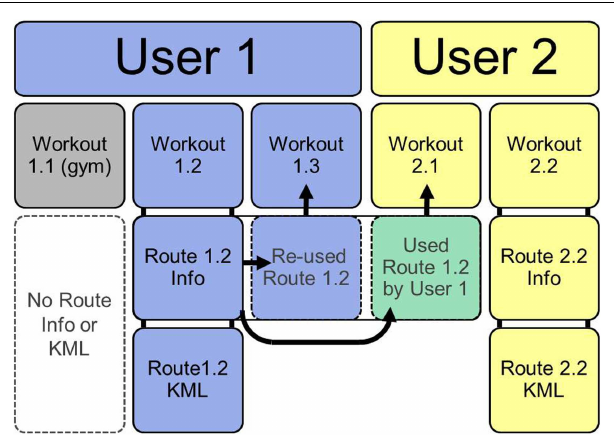
FIGURE 1 | Structure of MapMyFitness data . If users log workouts that do not have geographic information (e.g., in a gym) no route information or route KML is created (workout 1.1). Most workouts are logged by tracking a route.This creates a route information file and a route KML of the geographic path (workout 1.2 and 2.2). Once a route is saved, it can be re-used by the same user for a new workout (workout 1.3) or by another user for a new workout